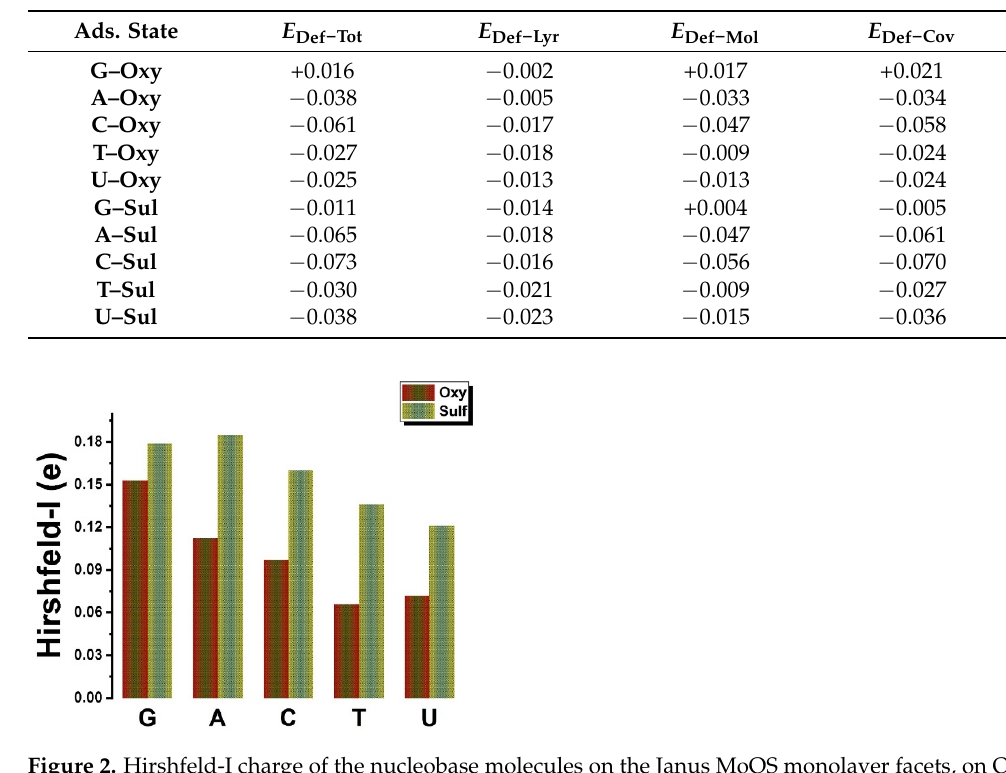
Figure 2. Hirshfeld-I charge of the nucleobase molecules on the Janus MoOS monolayer facets, on O layer and on S layer, respectively.